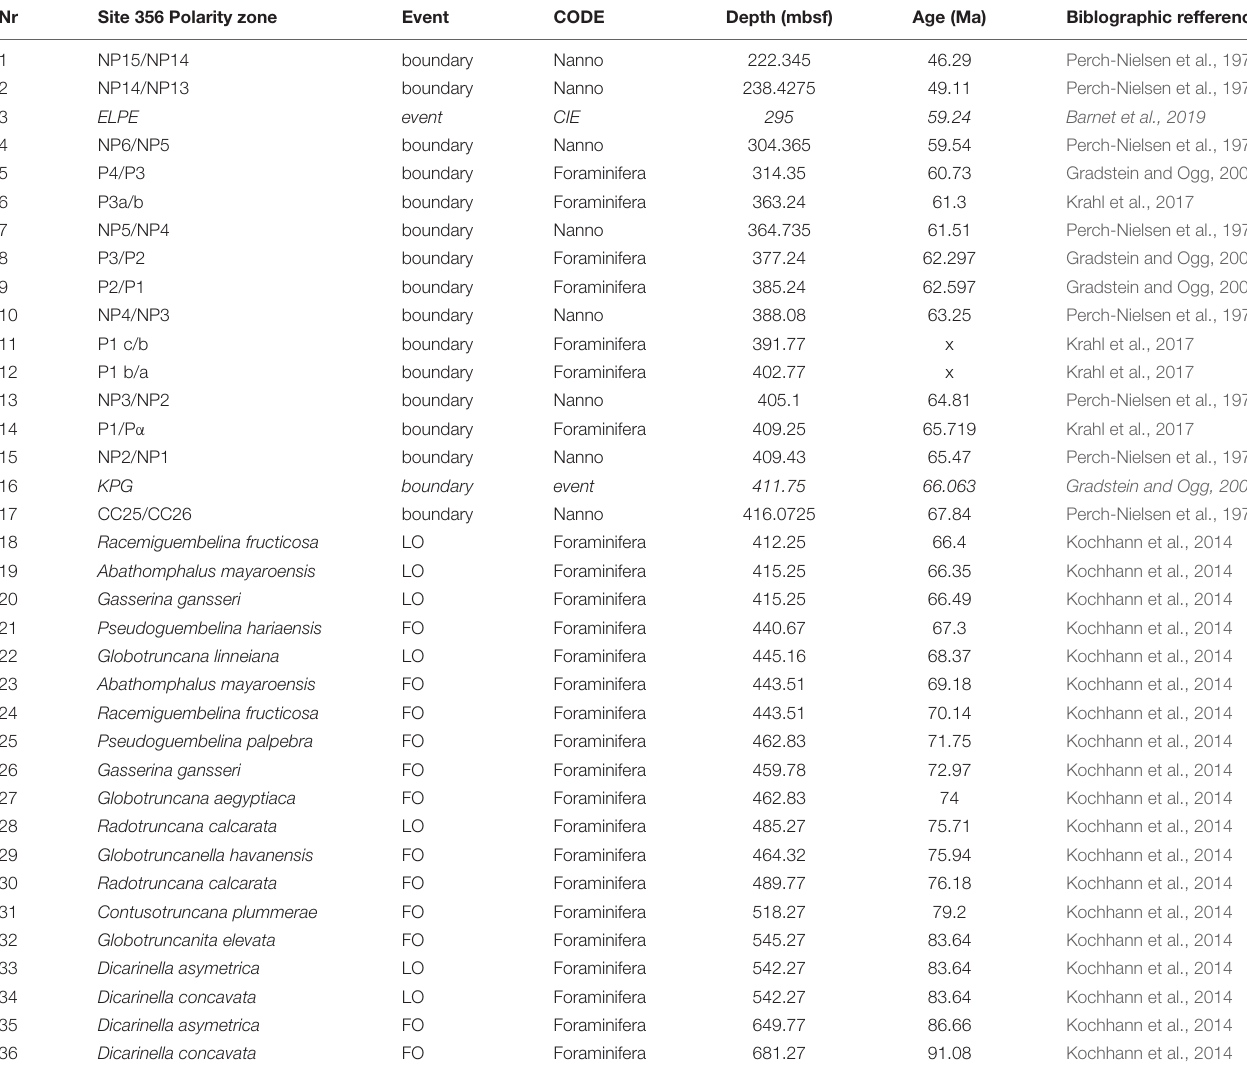
TABLE 1 | Tie-points from previous studies used for the development of the age model for Site 356 in this